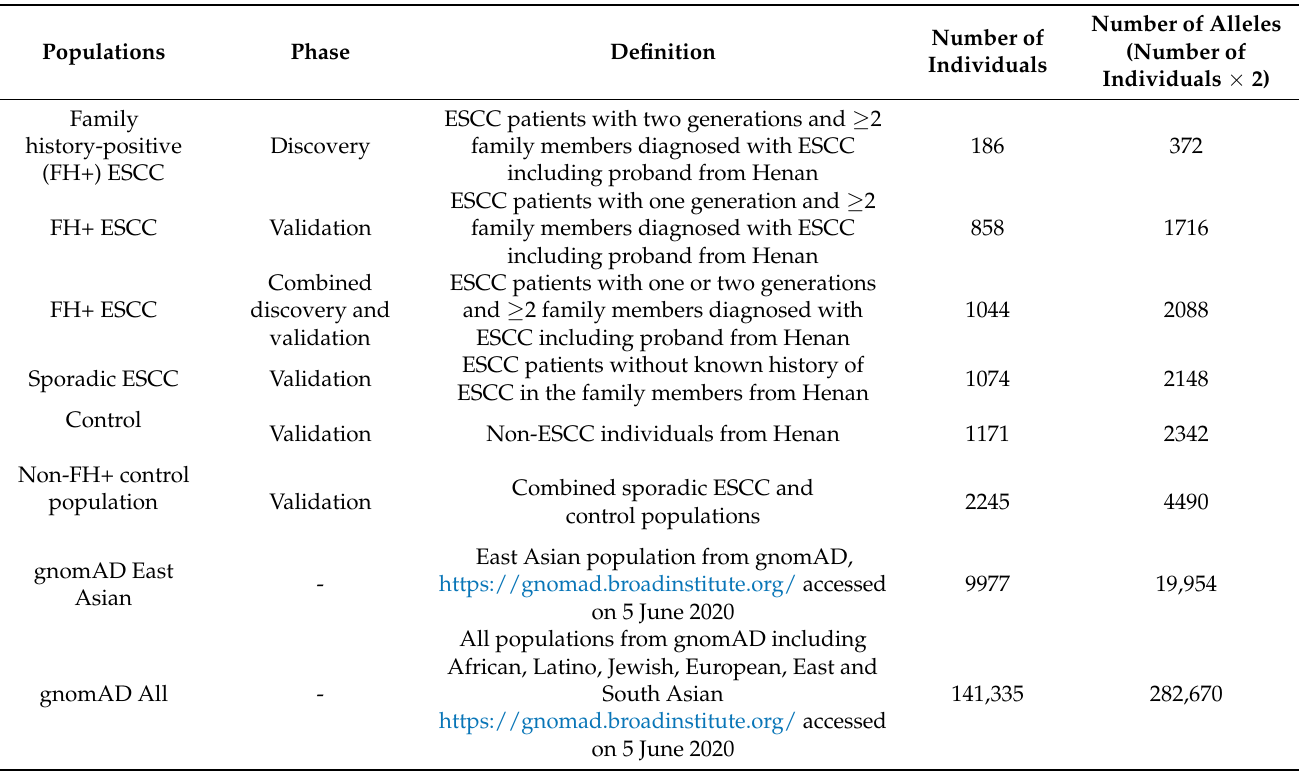
Table 1. Details of study